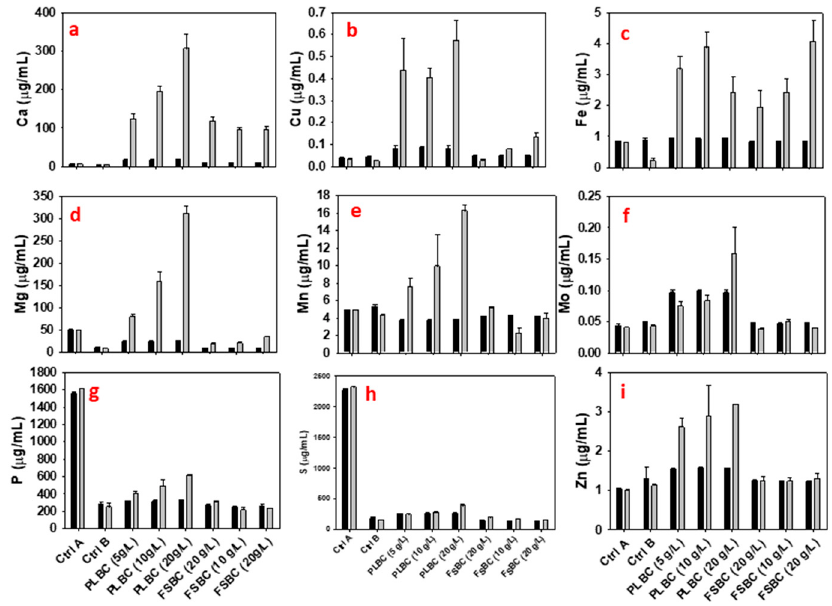
Figure 4. Concentrations of calcium, copper, iron, magnesium, manganese, molybdenum, phospho- rus, sulfur, and zinc ( a – i ) in PLBC and FSBC cultures of P. polymyxa at 0 h (black color) and at the end of fermentation (gray color).